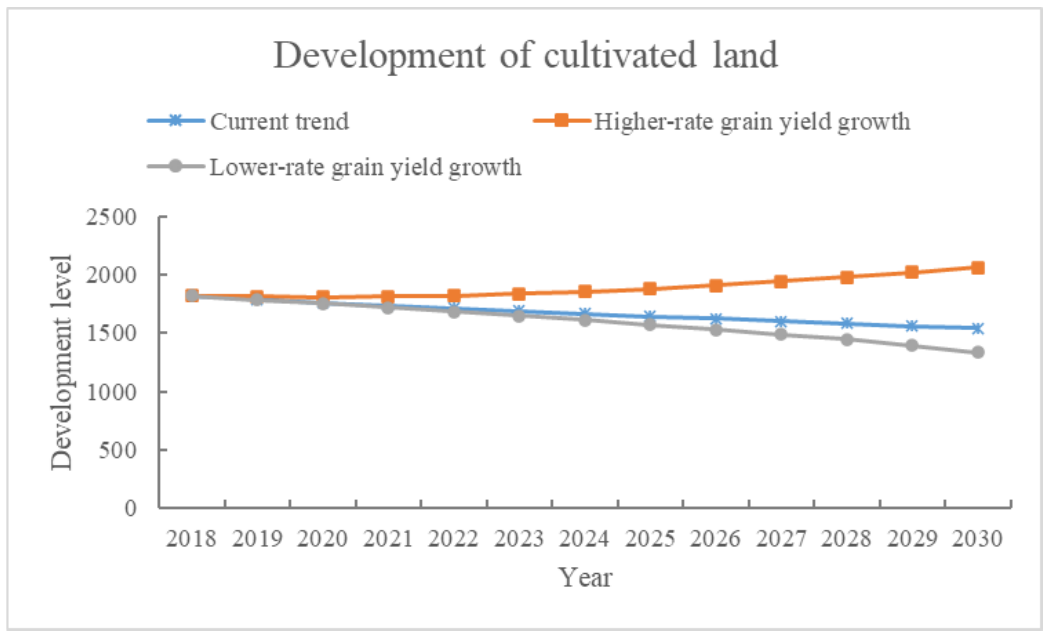
Figure 4. Development of cultivated land under three scenarios.